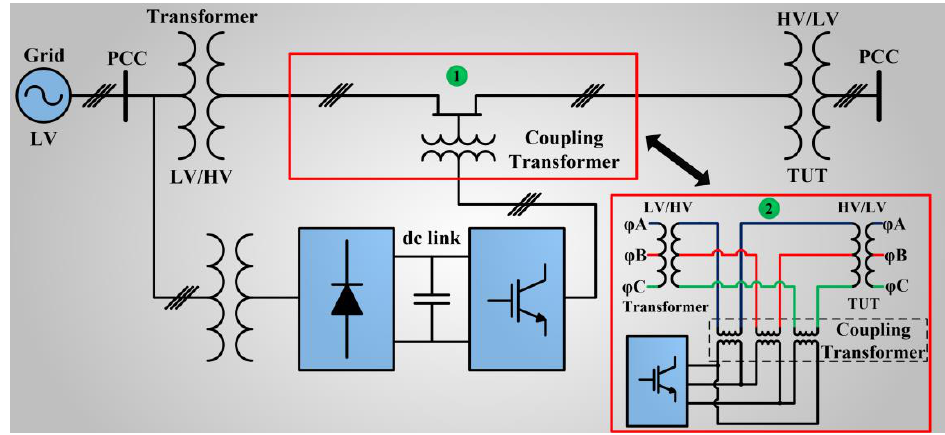
Figure 4. Structure of the system and connection of the power electronics converter.